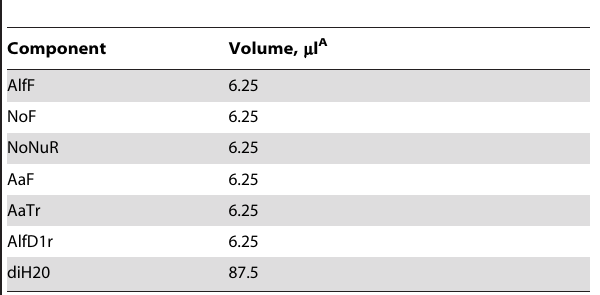
Table 9. Preparation of 125 m l primer stock for V. dahliae–V. longisporum lineages multiplex PCR assay sufficient for 50 25- m l PCR reactions.